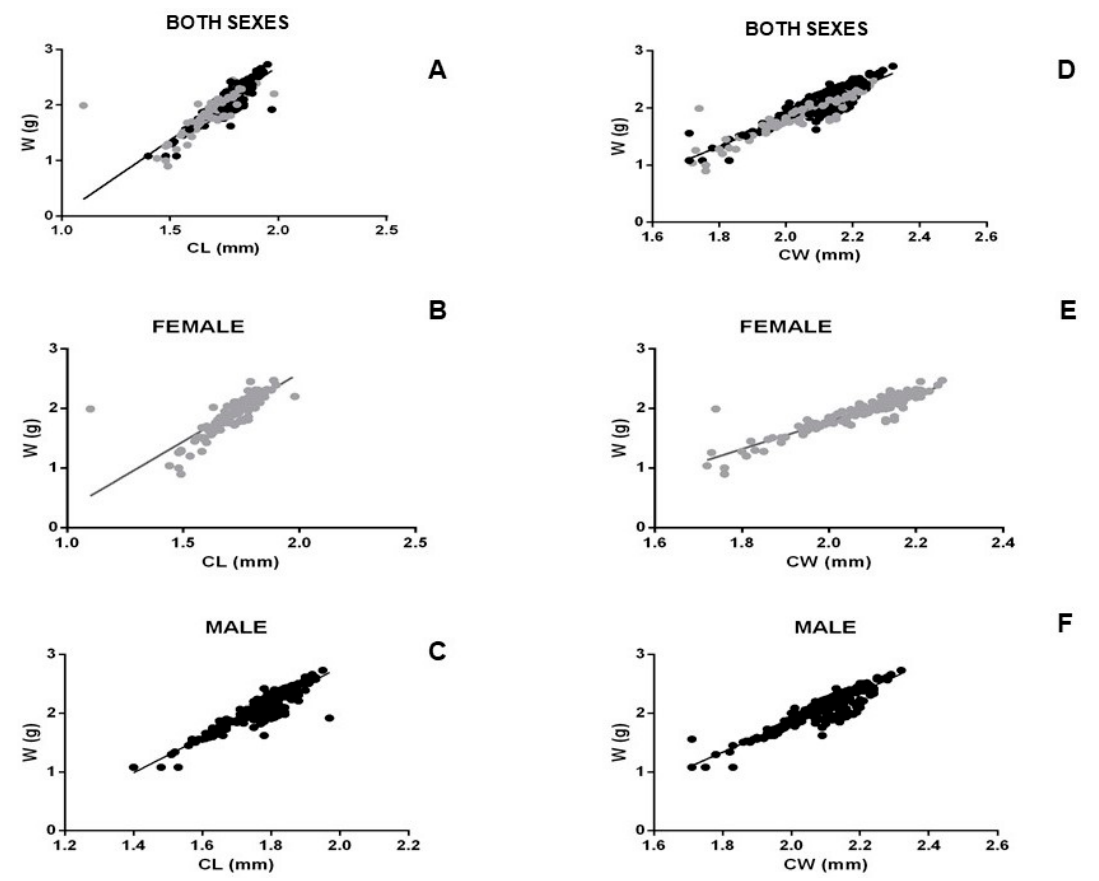
Figure 2. CL–W relationships (log transformed data), ( A ) both sexes, ( B ) female crabs, ( C ) male crabs. CW–W relationships (log transformed data). ( D ) both sexes, ( E ) female crabs, ( F ) male crabs.